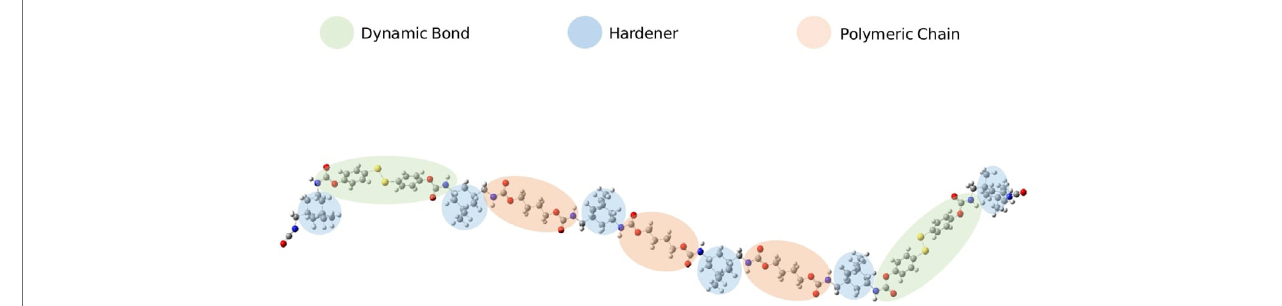
FIGURE 4 | Molecular chain model of the IP material used in the molecular dynamics simulations.